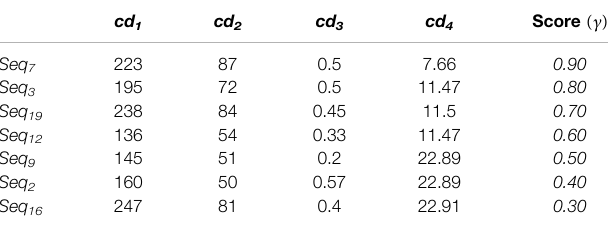
TABLE 5 | Learning subset of sequences and score given by the expert.